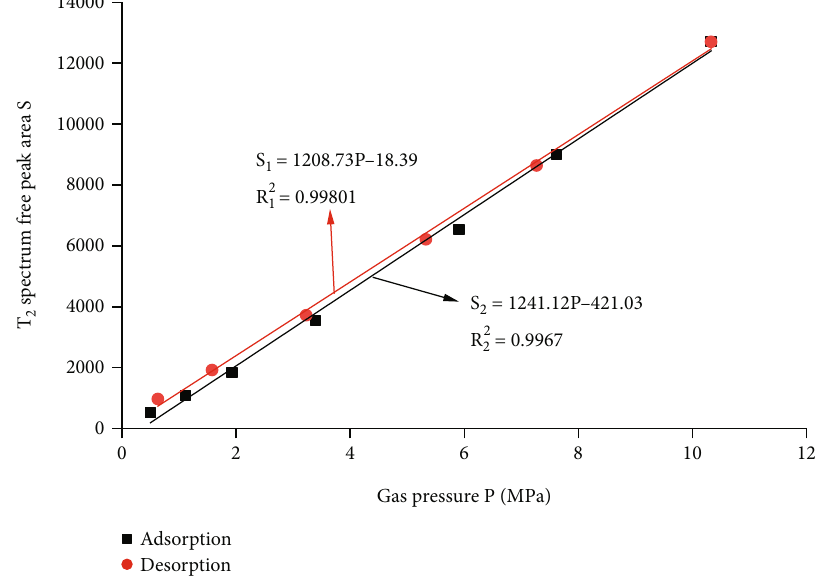
Figure 9: Free peak area and gas pressure